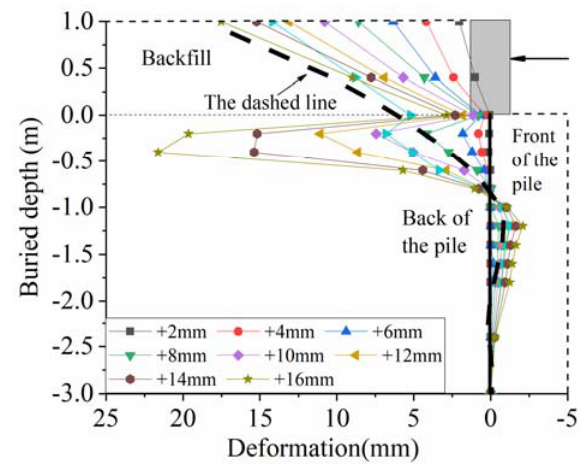
Figure 21. Distribution of horizontal deformation of specimen under positive displacement loads.